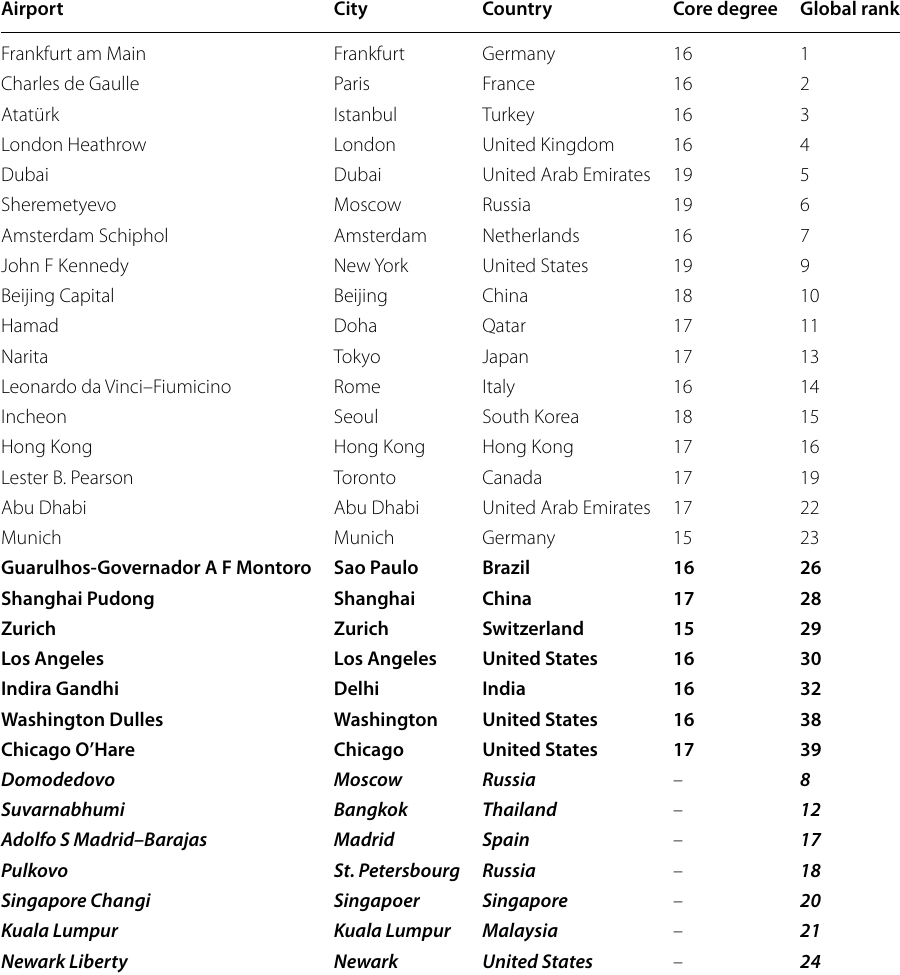
Airports not in the top 24inter-regional hubs are in bold. The core degree of a node is its number of links in the maximum k-core. Global rank is the rank in the large local component. Airports in the top 24 inter-regional hubs and not in the k-core are in